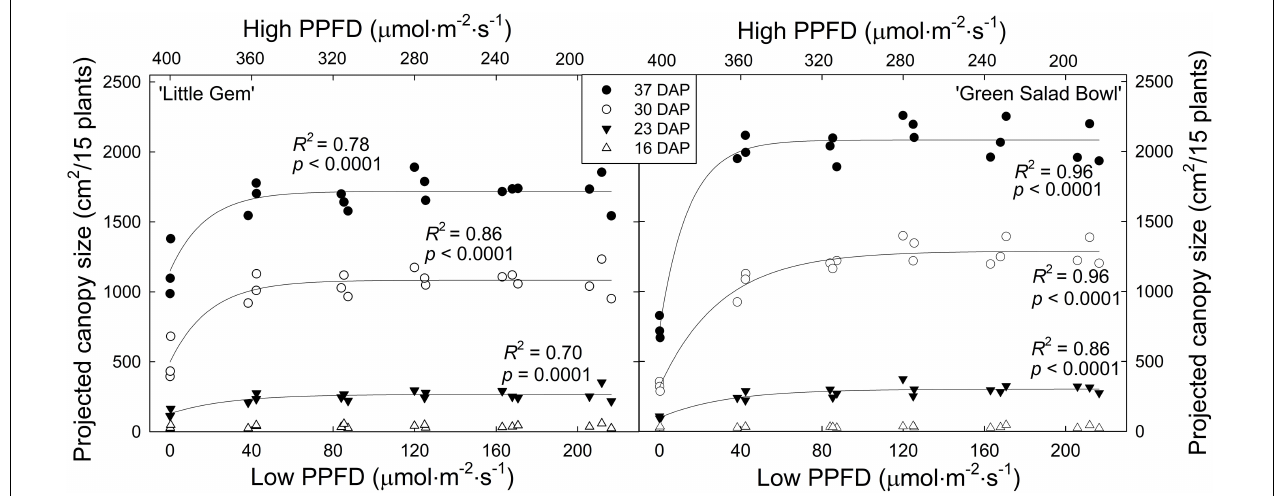
FIGURE 1 | Projected canopy size of ‘Little Gem’ and ‘Green Salad Bowl’ lettuce ( Lactuca sativa ) at 16, 23, 30, and 37 days after planting (DAP), measured on experimental units consisting of 15 plants. Plants were grown under fluctuating photosynthetic photon flux density (PPFD), with PPFD changing every 15 min between high and low intensities ( ∼ 400/0, 360/40, 320/80, 280/120, 240/160, and 200/200 µ mol · m − 2 · s − 1 ). Identical symbols represent the three replications of each treatment.